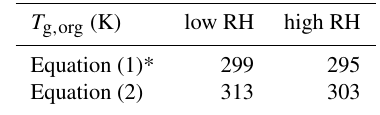
* Compounds with M > 450 gmol − 1 were excluded from the